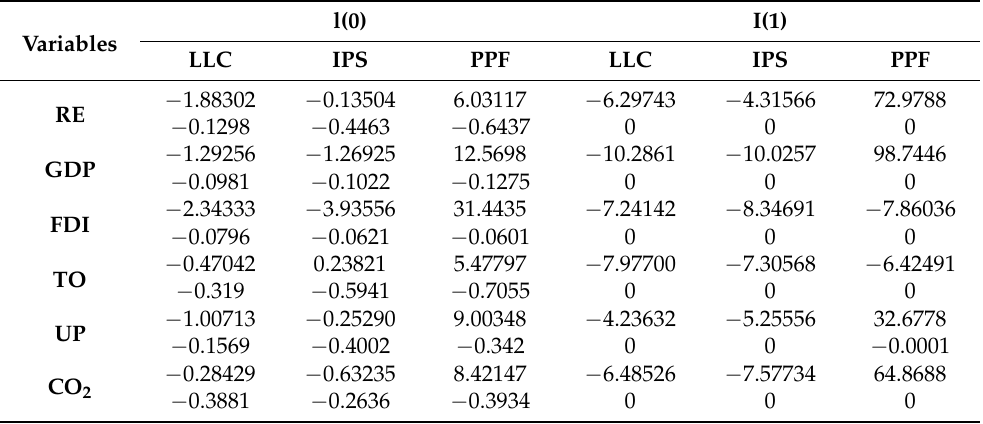
Table 3. Results of Panel Unit Root.